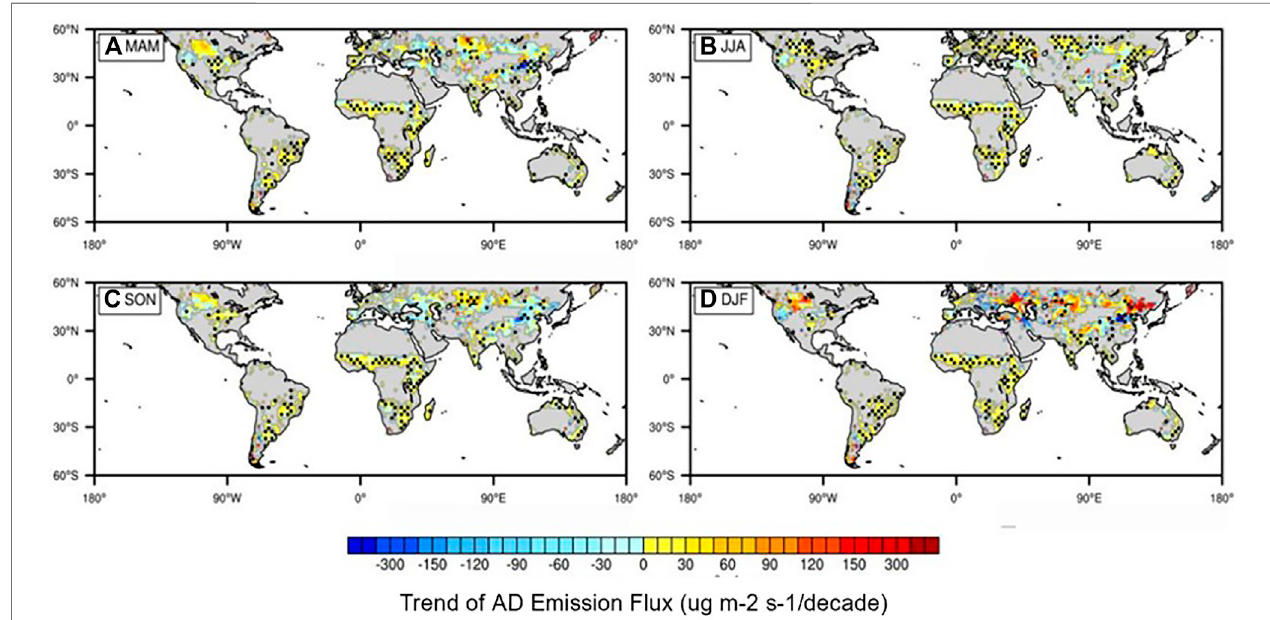
Frontiers in Earth Science |